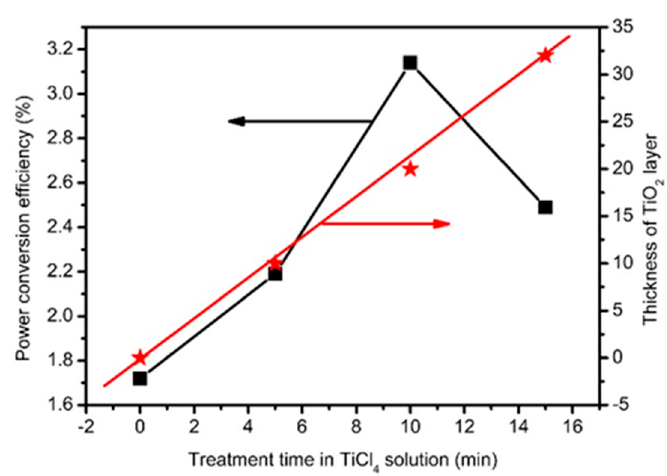
Figure 6. Relative variation of power conversion efficiency, and TiO 2 passivation layer thickness with different immersing time.